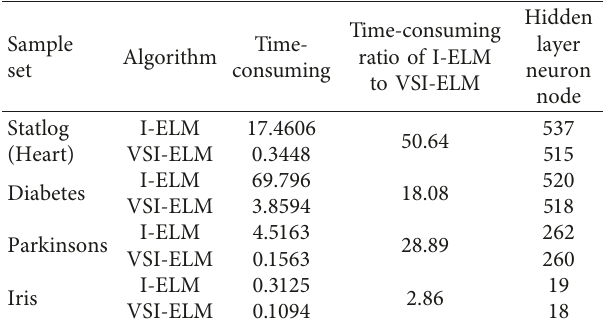
Table 4: Performance comparison of VSI-ELM and I-ELM in the UCI set classification